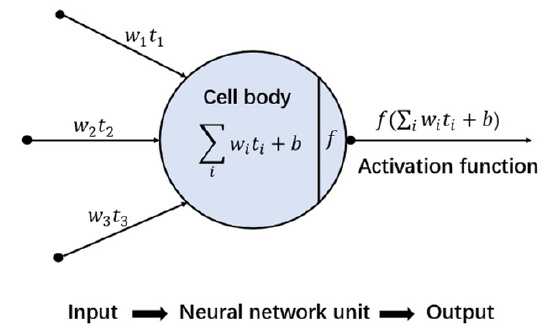
Figure 4. An illustration of a neuron.